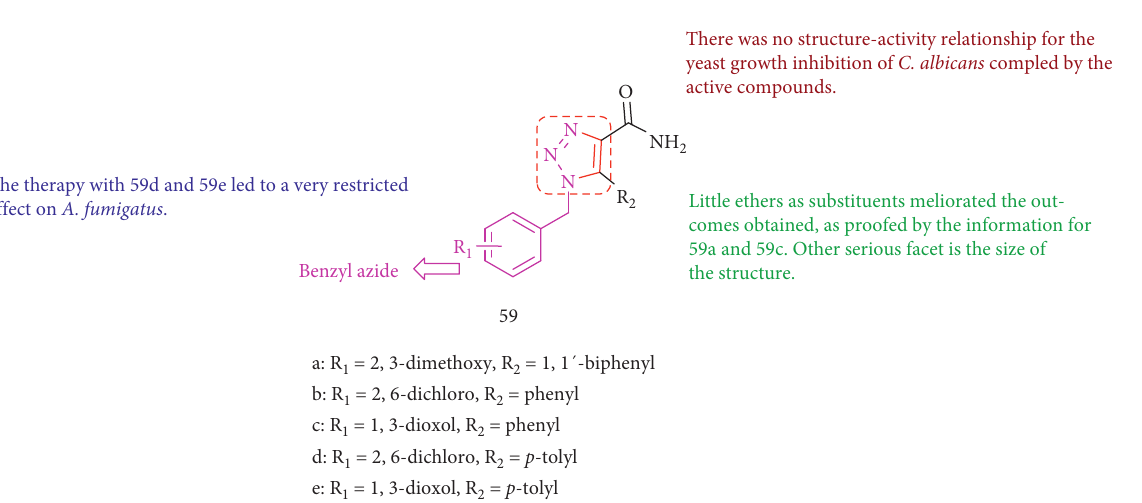
Figure 15: Chemical structure of novel benzylic